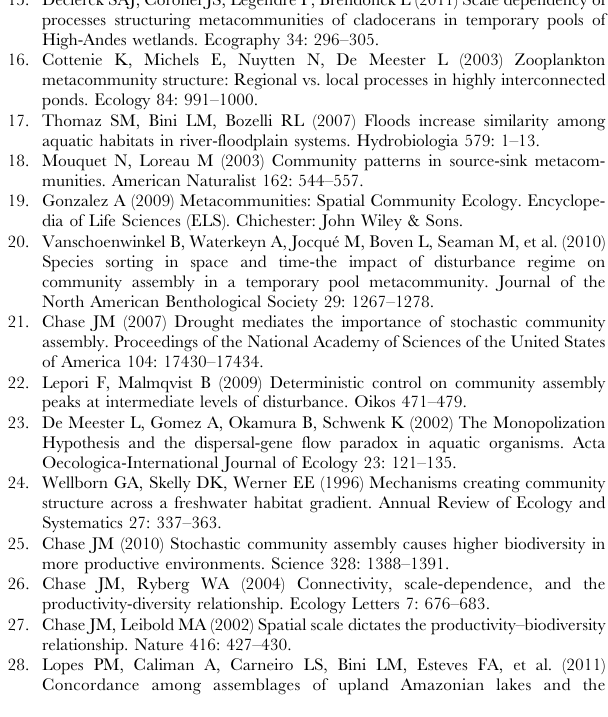
Table S4 Linear mixed-effects models of zooplankton beta diversity measured as the mean Bray-Curtis and Simpson distances to group centroid for disturbance data. Summary of the linear mixed-effects models of zooplankton beta diversity measured as the mean Bray Curtis (DistC BC ) and Simpson (DistC Sim ) distance to group centroid for disturbance data (permanent and temporary aquatic systems from Macae´ and Caraja´s). Marginal R 2 represents the variance explained by fixed factors. Table S5 Linear mixed-effects models of environmental heterogeneity for connectivity and disturbance datasets. Summary of the linear mixed-effects models of environmental heterogeneity (Env) measured as the mean Euclidean distance to group centroid for connectivity (connected and isolated permanent lakes from all studied regions) and disturbance datasets (permanent and temporary aquatic systems from Macae´ and Caraja´s). Marginal R 2 represents the variance explained by fixed